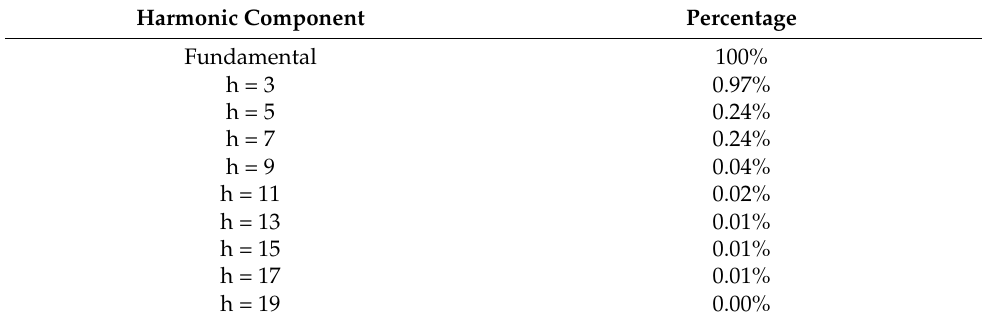
Table 3. Odd harmonic grid current distortion in percent of the fundamental component with APF.